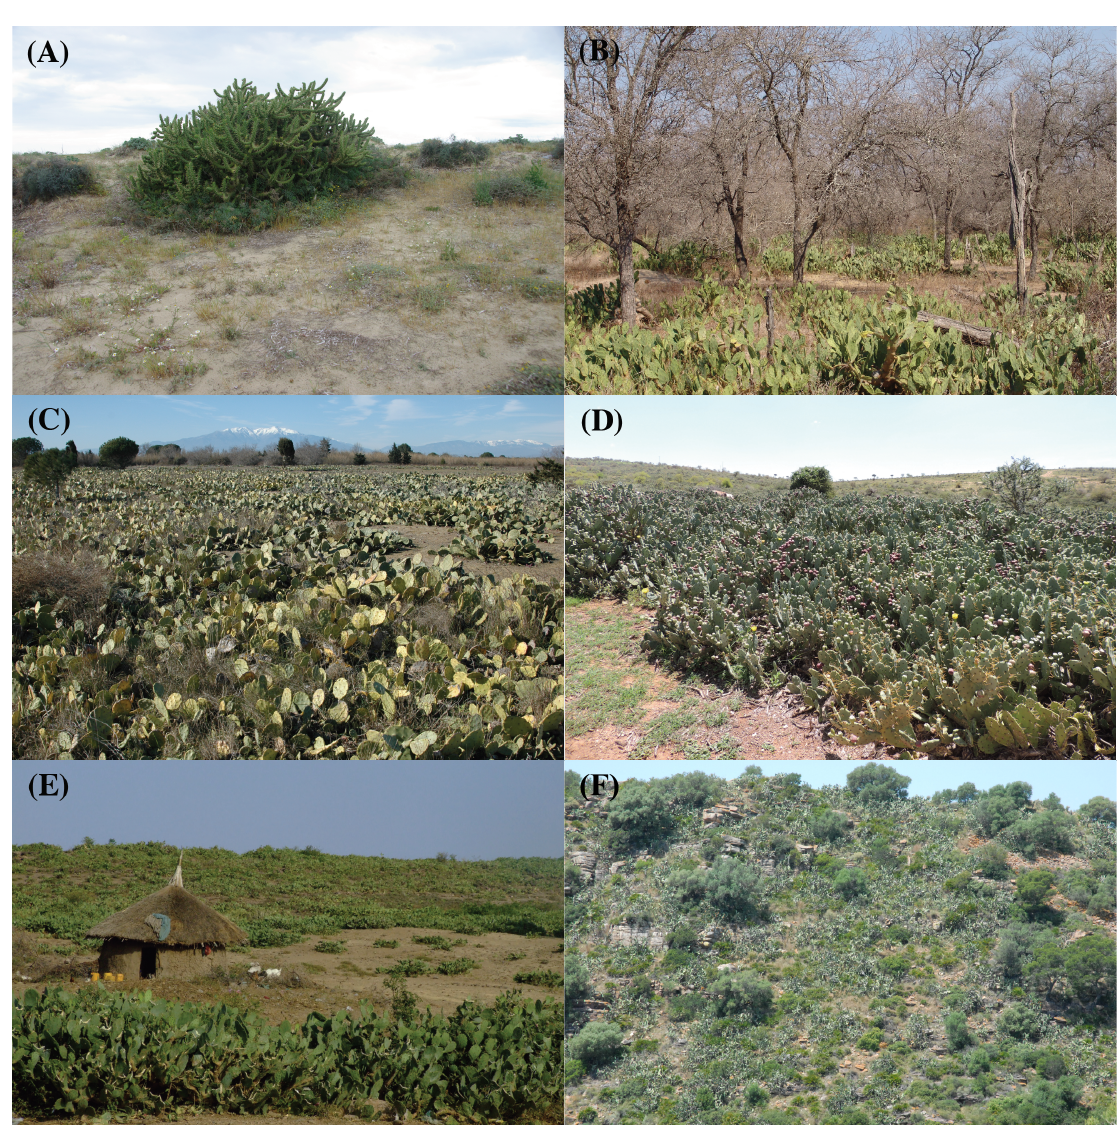
Figure 3. Examples of cactus invasions in different parts of the world. ( A ) Austrocylindropuntia sp. invading sand dunes in Sardinia, Italy. Opuntia stricta invading ( B ) a semi-arid savanna in Kruger National Park, South Africa, ( C ) grey dunes in southern France and ( D ) a rural area in Kenya. Opuntia ficus-indica invading ( E ) a village in Ethiopia and ( F ) Calderona Natural Park in Valencia, Spain.